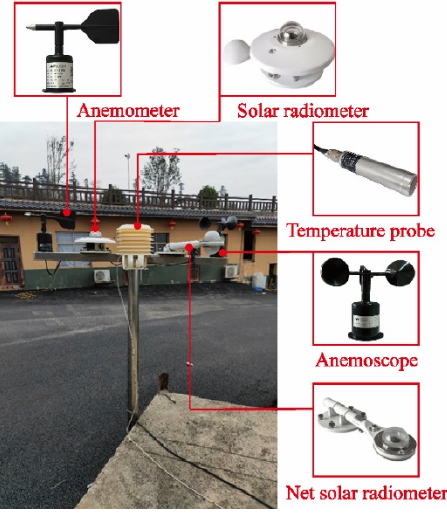
Figure 6. Environment monitoring system.